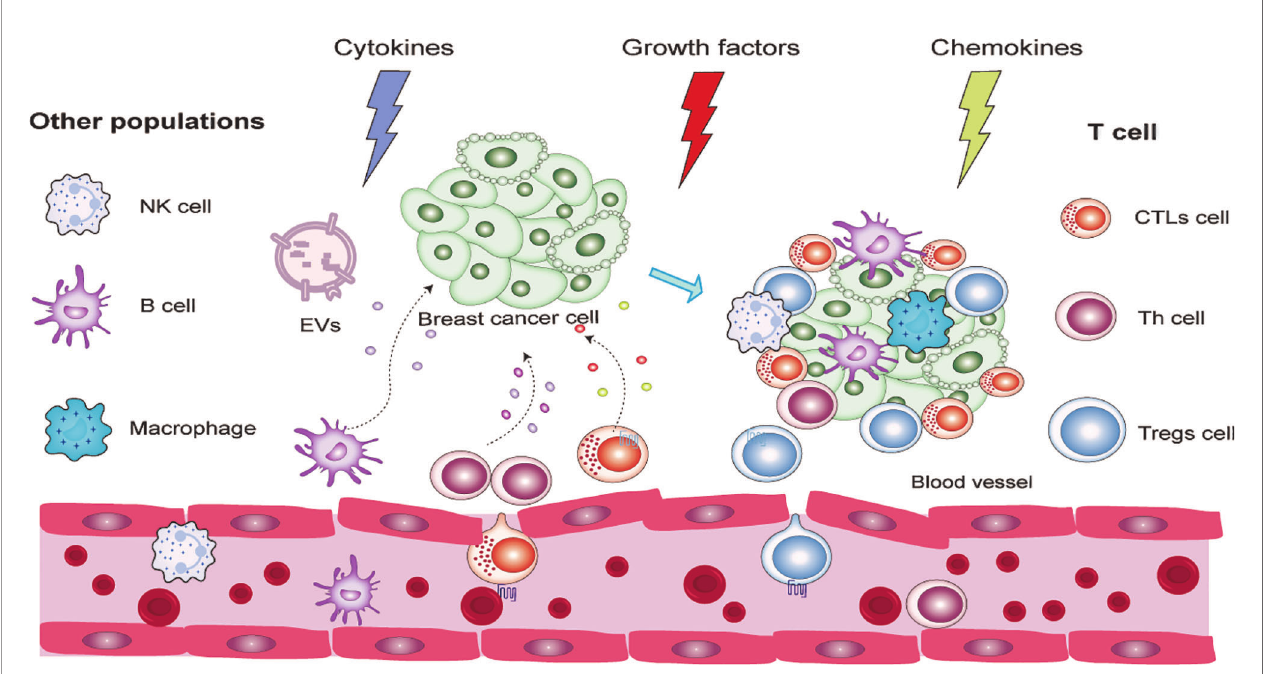
FIGURE 1 | Graphic representation of the development of Tregs. The location of origin of Tregs consisted of the thymus and secondary lymphoid tissue. The process involved in the thymus includes the selection of high-af fi nity CD25+ Treg cells and the expression of FOXP3 and other essential receptors expressed on the membrane through a complex signal transduction. The other process taking place in the secondary lymphoid tissue is attributed to the binding of PD-1 and PD-L1 and the cytokine TGF- b , but the inner mechanism remains